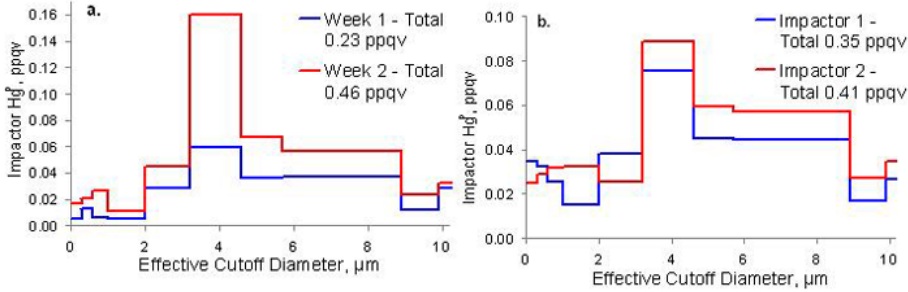
Fig. 2. Size Distribution of Hg P at Appledore Island (a) and Thompson Farm (b) for summer 2009 showing similar total Hg P at both sites with enhanced levels of coarse size